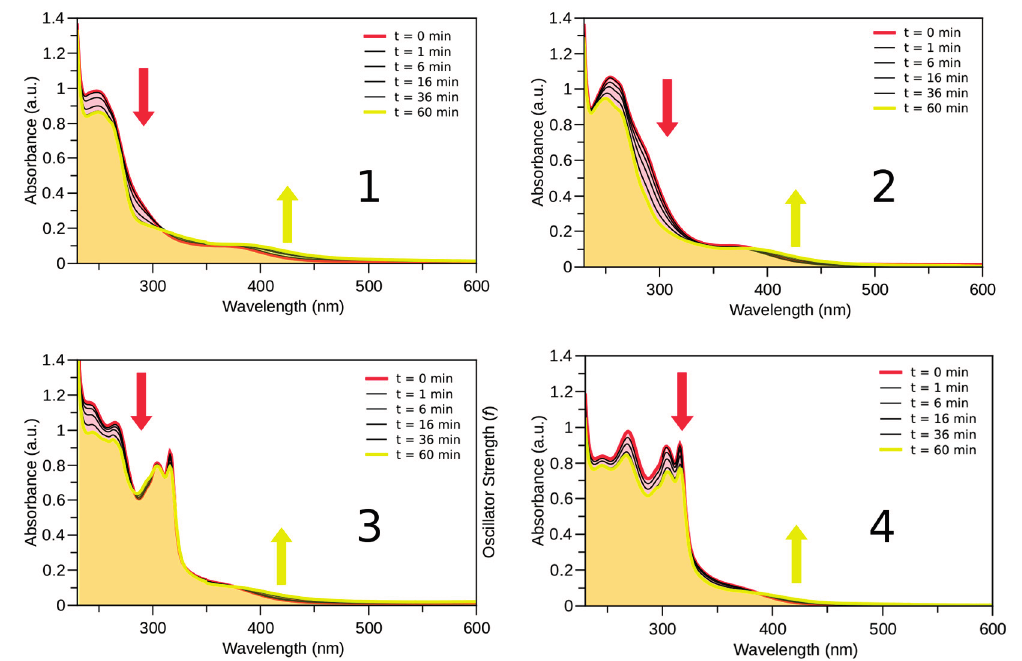
Figure 7. Photolysis ( λ exc = 400 nm, 2 mW·cm − 2 ) of complexes 1 – 4 (60 μ M) in aqueous solution followed by UV-Vis.